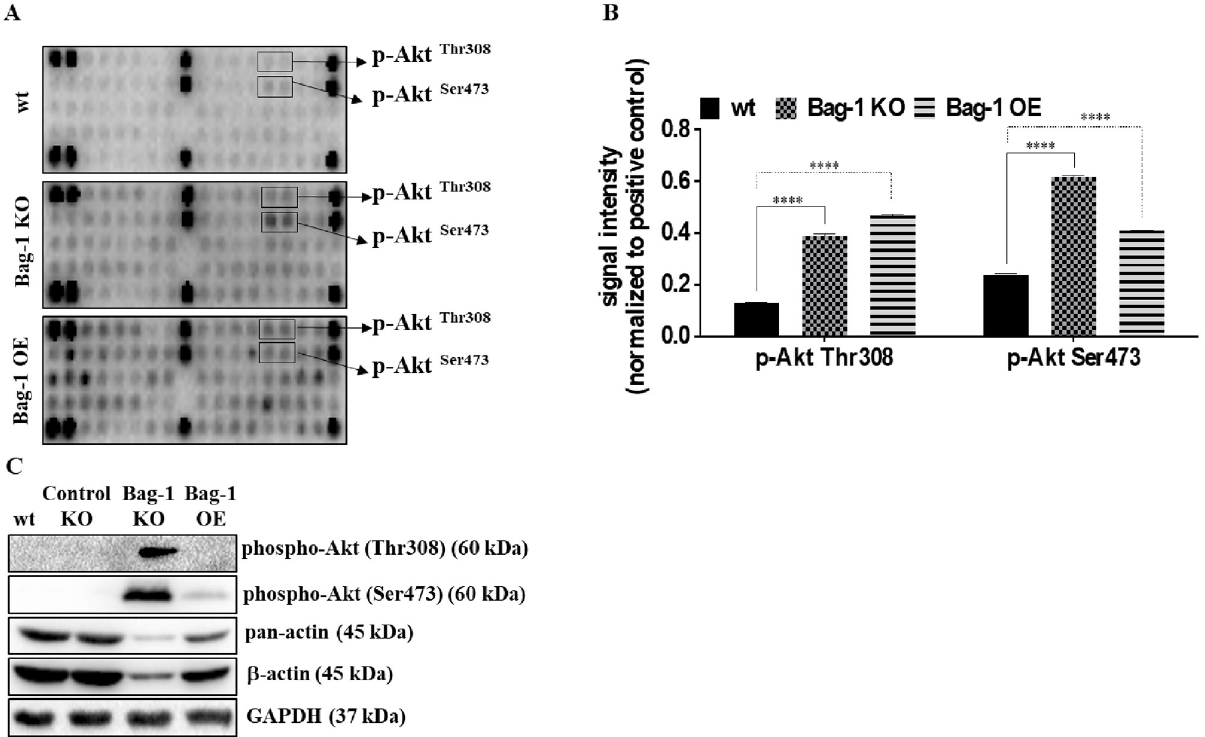
Fig 3. Expression profiles of phosphorylated RTKs and signaling routes in MCF-7 wt, Bag-1 KO and Bag-1 OE cells. A) The representative image of PathScan 1 RTK Signaling Antibody Array panel that showing the expression of activated RTKs in wt, Bag-1 KO and Bag-1 OE MCF-7 cells. B) The bar graphs showed the quantification of the signal intensity of phospho-Akt Ser 473 and phospho-Akt Thr308 proteins. The mean ± SD of three repetitive experiments were analyzed by Two-way ANOVA, Tukey’s multiple comparison tests ( ���� p < 0.0001). C) Confirmation of selected phosphorylated protein expression by immunoblotting assay. GAPDH was used as a loading control. The relative densitometry analysis represented the mean ± SD of three independent experiments. ( ��� p = 0.0003, ���� p < 00001 by Two-way ANOVA, Tukey’s multiple comparison test, S3B Fig).